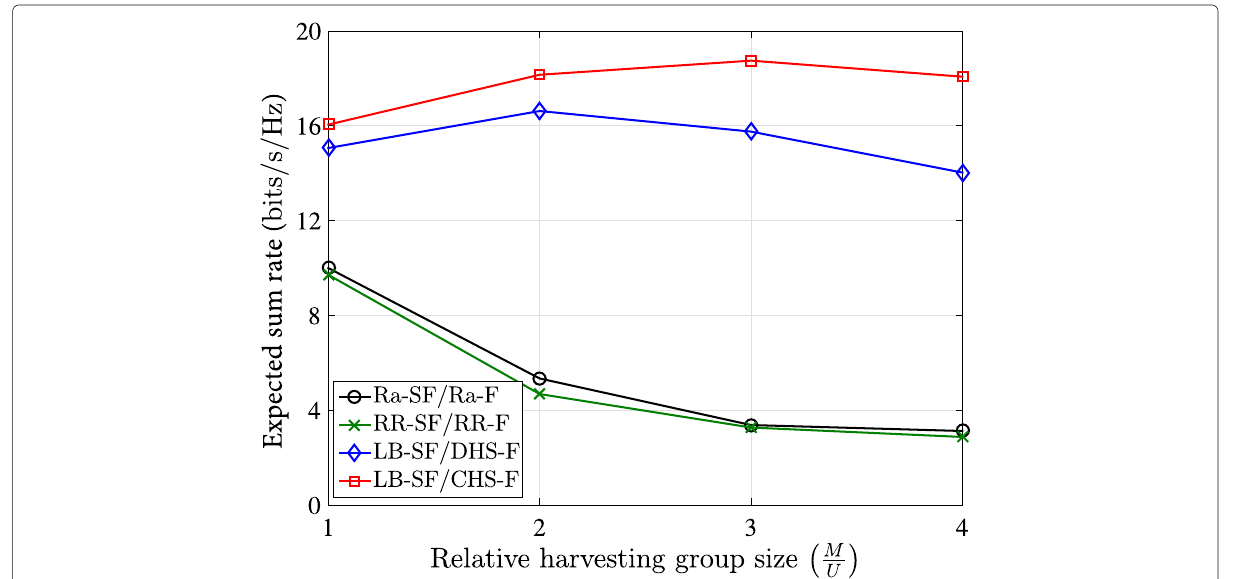
Fig. 10 Expected system sum rate vs relative size of the harvesting user group. Expected system sum rate as a function of the relative size of the harvesting user